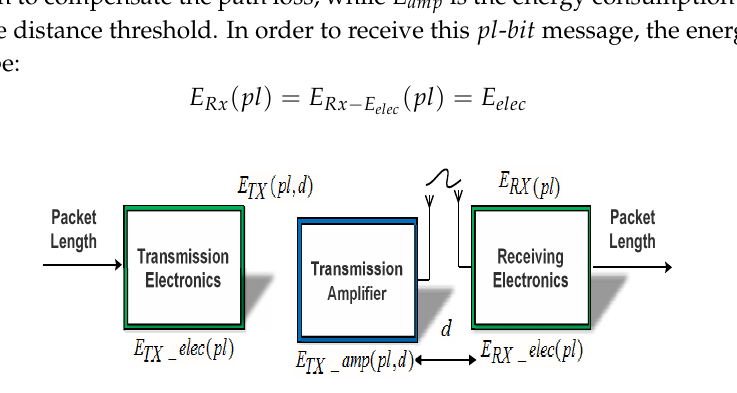
Figure 1. Radio model used in the proposed routing